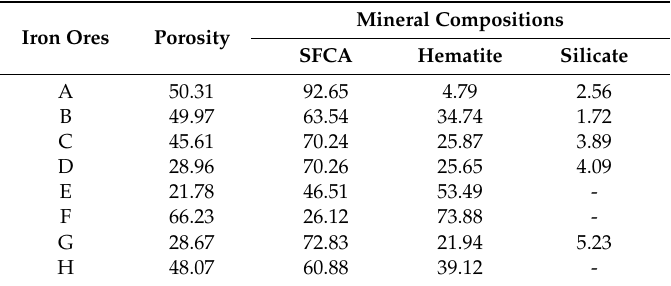
Table 4. The mineral compositions and porosity of iron ores sinter (area: %). Iron Ores Porosity